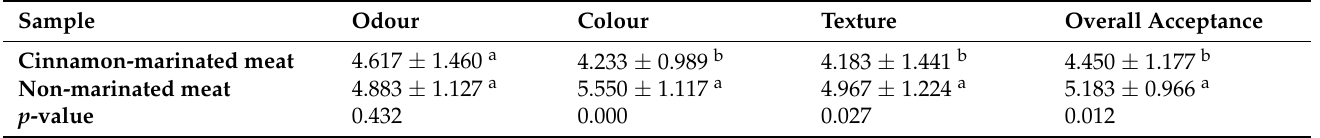
Table 5. Sensory of cinnamon-marinated meat and control (non-marinated meat) after 24